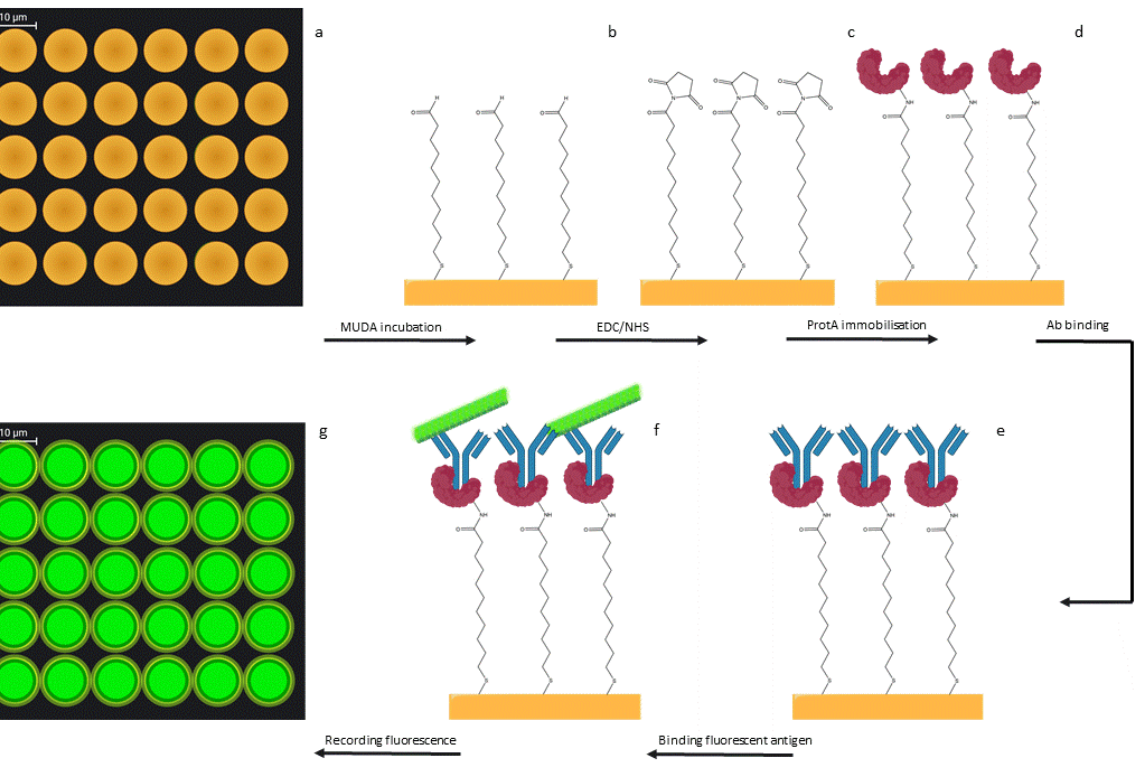
Figure 7. Schematic representation of the silicon platform functionalization. Silicon surface with gold clusters ( a ), overnight incubation with MUDA ( b ), EDC/NHS activation ( c ), protein A covalent immobilization ( d ), protein A binding anti-tubulin Ab ( e ), anti-tubulin Ab binding fluorescent tubulin ( f ), schematic representation of fluorescence recorded ( g ). Image created with BioRender.com (accessed on 7 August 2021.